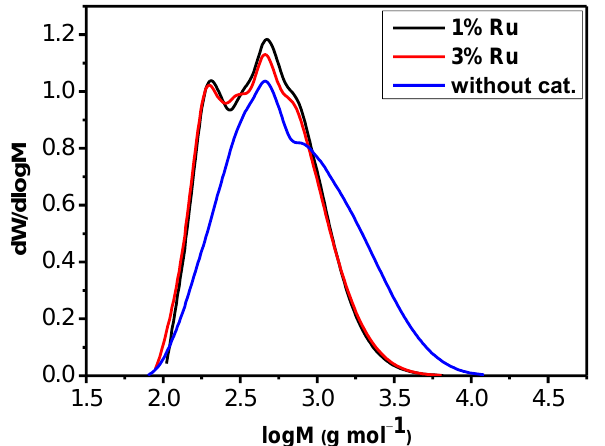
Figure 6. The effect of Ru content on the molecular weight distribution of the liquid products of spruce wood RCF at 225 °С for 3 h. Table 4. Effect of the Ru content on molecular weight characteristics of the liquid products of spruce wood RCF at 225 °C for 3 h.